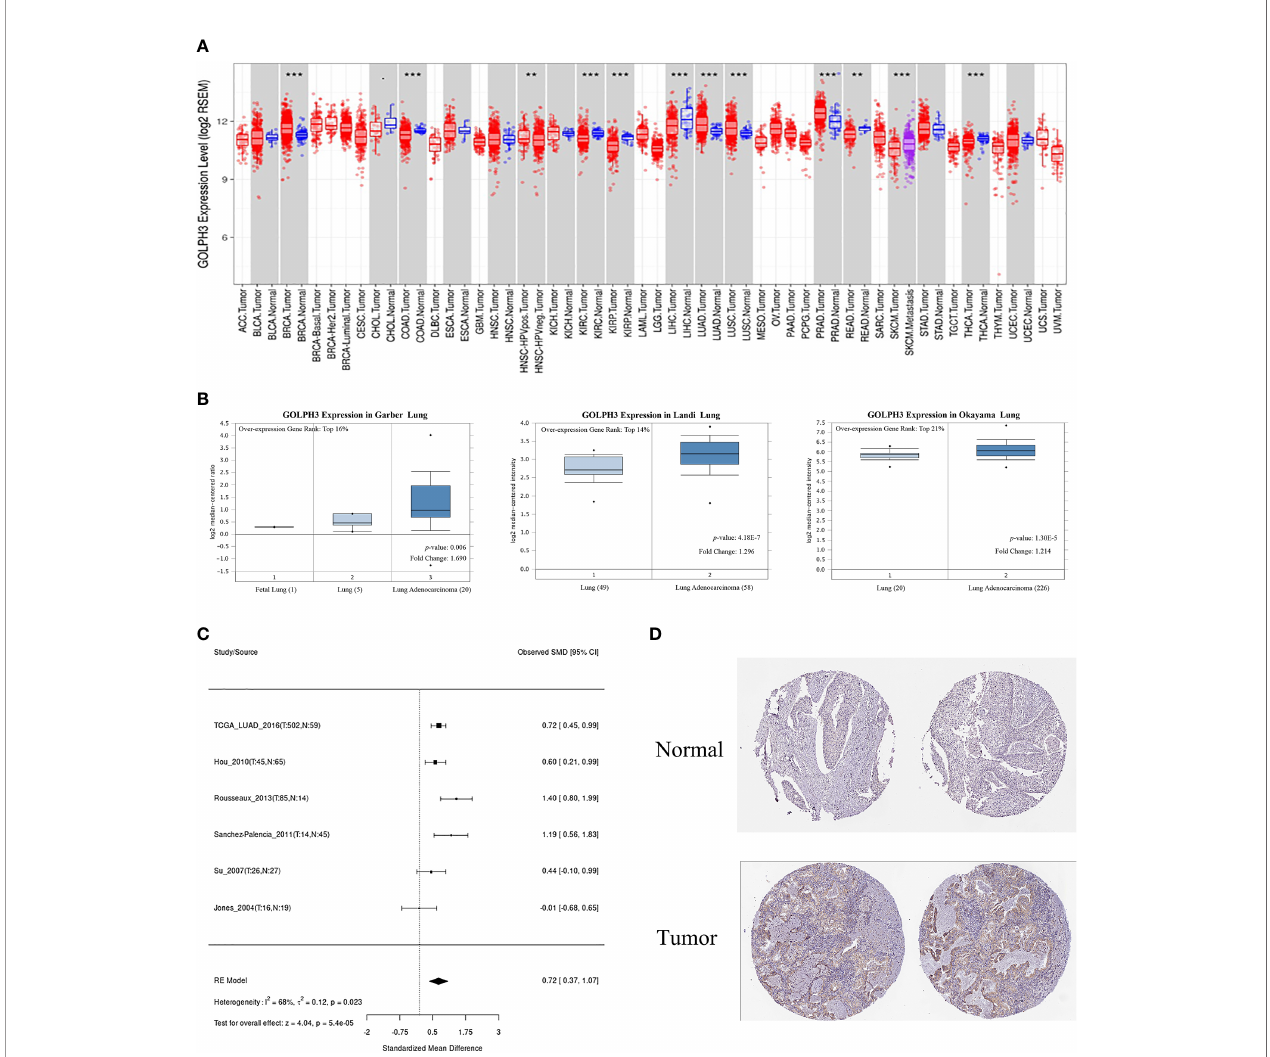
FIGURE 1 | The expression of GOLPH3 in LUAD. (A) GOLPH3 mRNA expression in human tumors (TIMER). (B) GOLPH3 mRNA expression in Garber lung, Landi lung, and Okayama lung (Oncomine). (C) The meta-analysis result of GOLPH3 mRNA expression in LUAD (LCE). (D) The protein expression of GOLPH3 in LUAD tissues (HPA). LUAD, lung adenocarcinoma; LCE, Lung Cancer Explorer; HPA, Human Protein Atlas. ** p < 0.01, *** p <